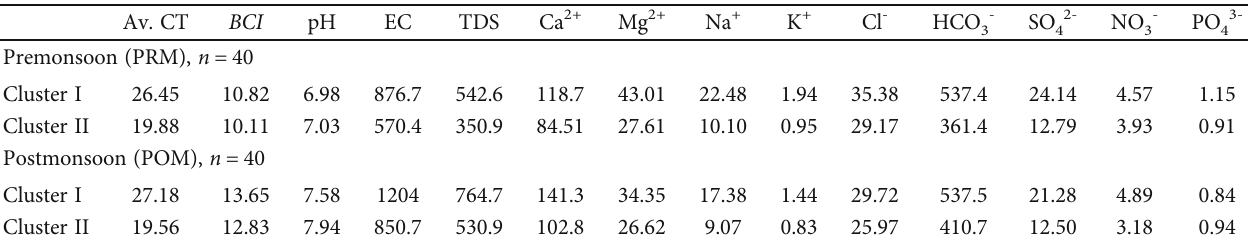
Figure 8: Spatial variation of clusters in the study area for (a) premonsoon and (b) postmonsoon. Table 5: Average variable ’ s value of 2 classes according to hierarchical cluster